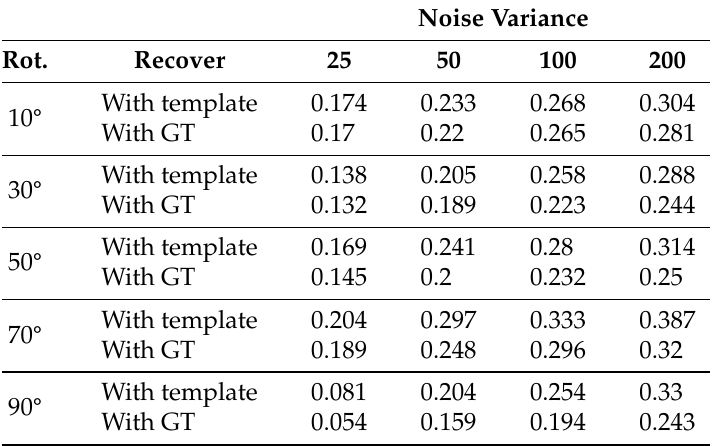
Table 2. Average BER for rotation attack with Gaussian noise. GT denotes ground-truth.